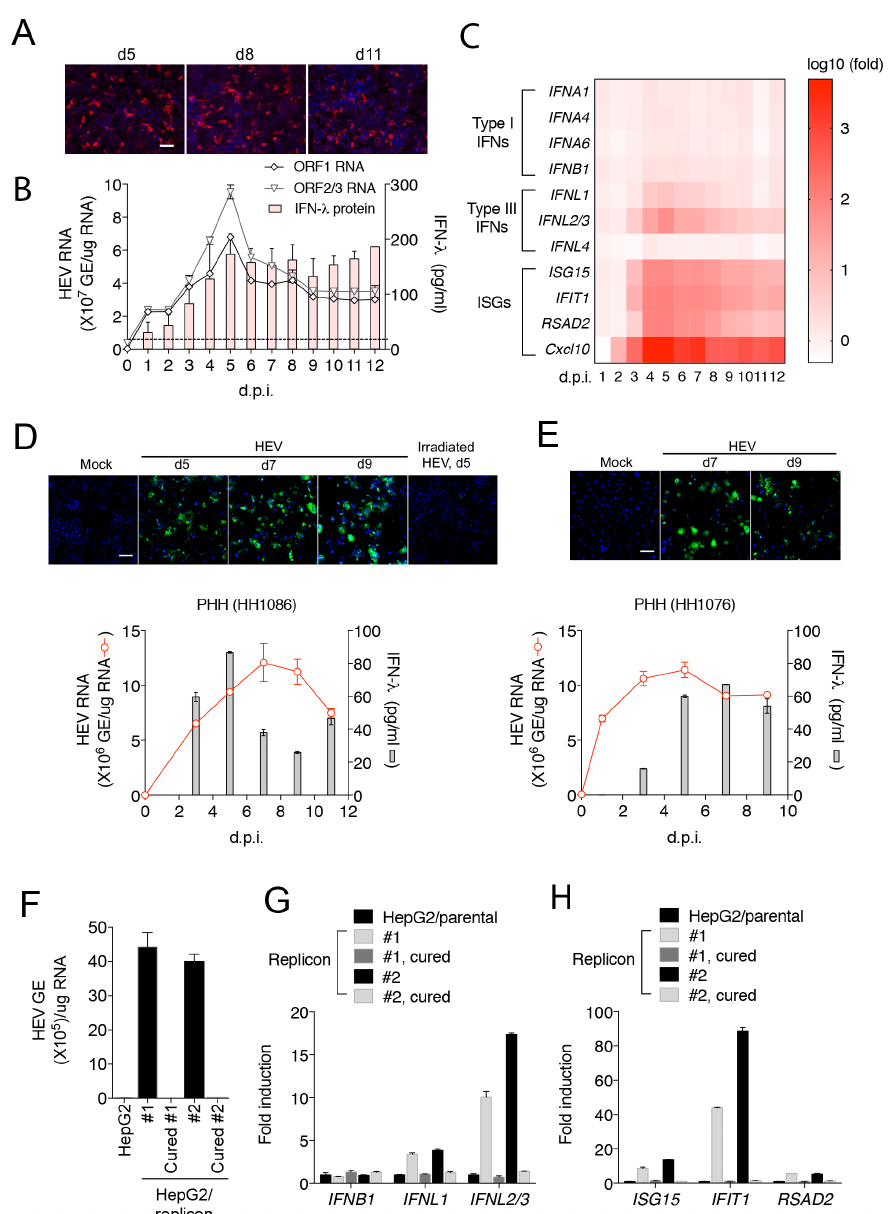
Fig 1. HEVinducesatypeIII-predominant IFNresponsein humanhepatocytes.(A) HepG2cellswere inoculatedwithHEV(1,000HEVgenomeequivalents(GE)/cell)andstainedwithanti-ORF2 antibodyatdifferent timesafterinoculation. CellswerecounterstainedwithDAPIfor DNA.Scalebar:100 μ m. (B) KineticsofHEV replicationandIFN secretionresponsesinHepG2cells.HEVRNAwasmeasured byquantitativeRT-PCRusing primerstargeting eitherORF1(representingthefull-length HEVgenome)orORF2/3(representing thesumofthe full-lengthandthesubgenomic HEVRNA).ConcentrationsofdifferentIFNs(IFN- α ,IFN- β ,andIFN- λ )intheculture supernatantsweremeasured byspecificELISA.OnlyIFN- λ proteinwasdetectedand,therefore, shown.Dotted linedenotesthedetectionoflimitofIFN- λ (15.6pg/ml).Theresultsshowthemean ± SEMoftheaverageofthe duplicatesineachof2 independentexperiments. ( C )KineticsofdifferentIFN andISG mRNAexpression inHEV- infectedHepG2cells.Dataareexpressedaslog 10 foldchangerelativetomock-infectedcells. (D-E )Kineticsof HEVreplicationandIFN productioninHEV-infectedprimaryhumanhepatocytes (PHHs).PHHsfromtwodifferent donors(HH1086andHH1076)wereinoculatedwithHEV(10 4 GE/cell),andatdifferentdayspostinoculation stainedwithchimpanzee immuneserum(ch1313)andDAPI(toppanels).CellsinoculatedwithirradiatedHEVdid notproducepositivesignal.Scalebar,100 μ m.Intracellular HEVRNAandsupernatantIFNswerequantifiedby qRT-PCRandELISA,respectively(bottompanels).IFN- α andIFN- β